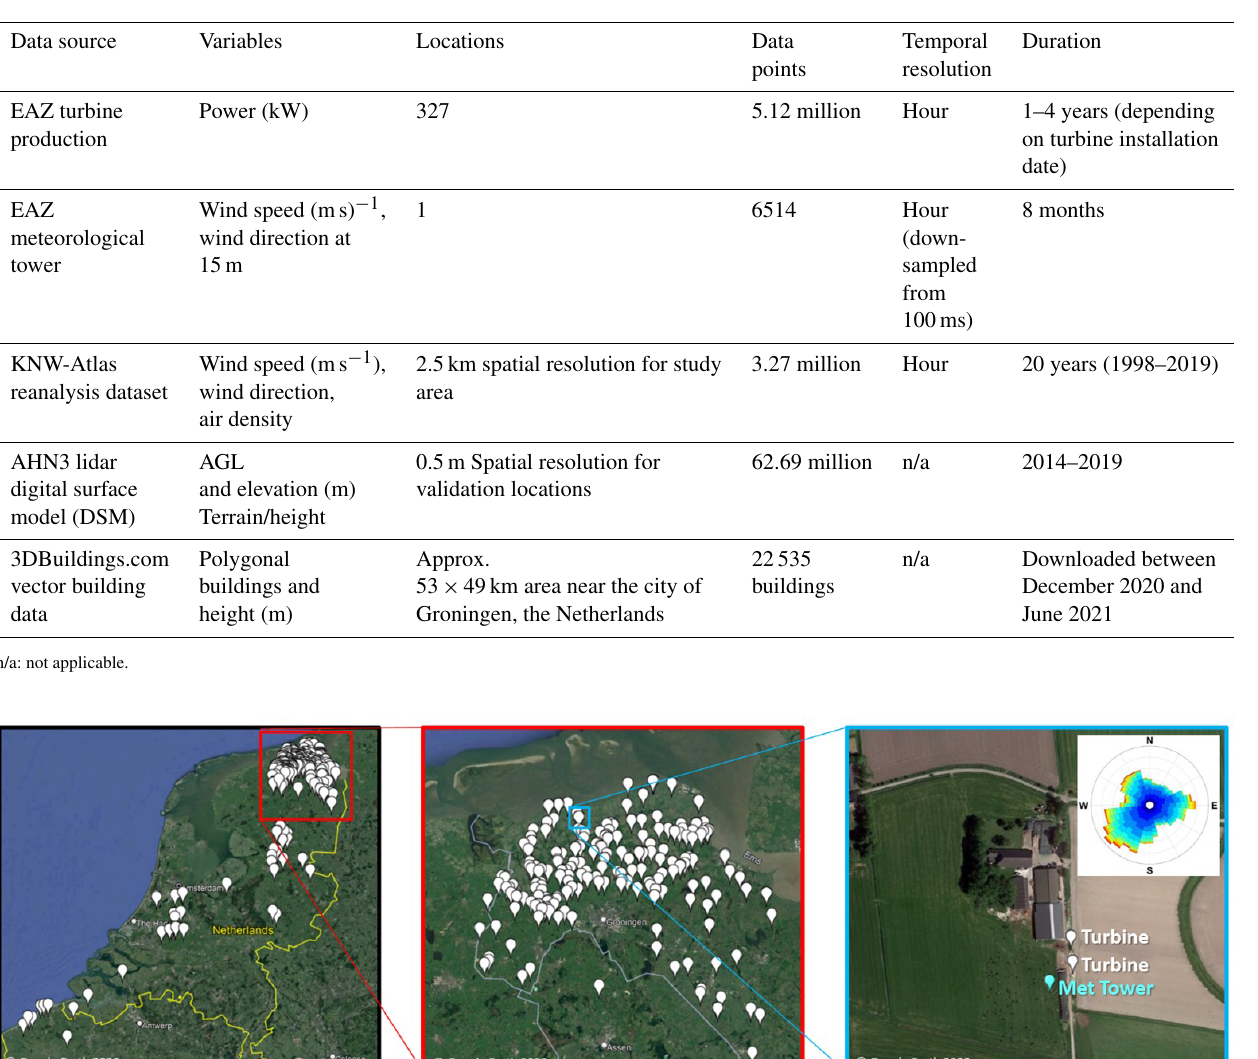
Table 1. Summary of data sources.